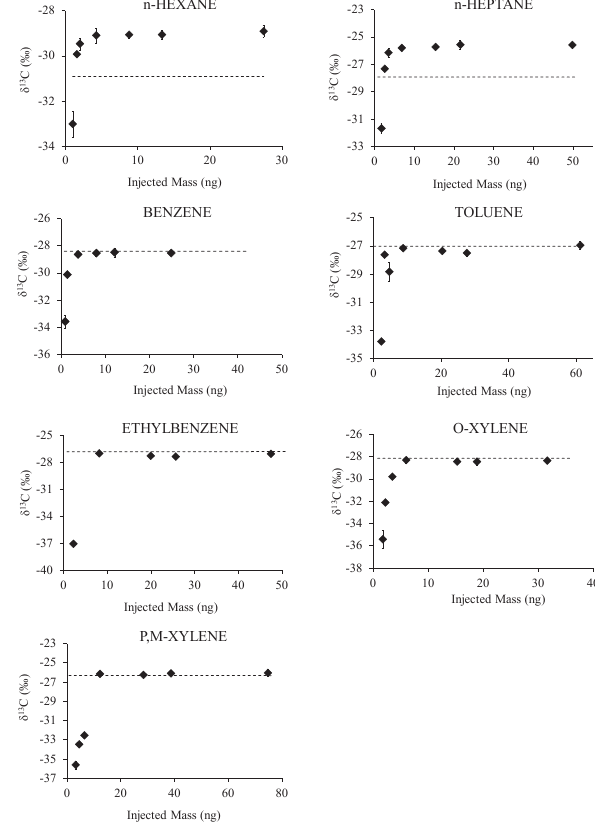
Figure 3. Plot of δ 13 C values versus injected mass measured on- line using TSPS-GC-IRMS. Dashed lines are the reference (offline) δ 13 C values. For p,m-xylene the average of the p-xylene and m- xylene offline values is given since the mixtures contained equal masses of both